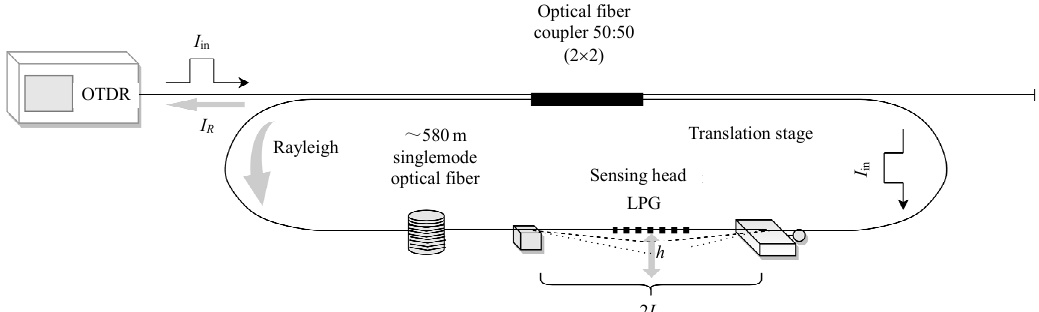
Fig. 1 Curvature sensor measuring setup - the signal is introduced by the OTDR, which uses the backscattered light to make sensitivity